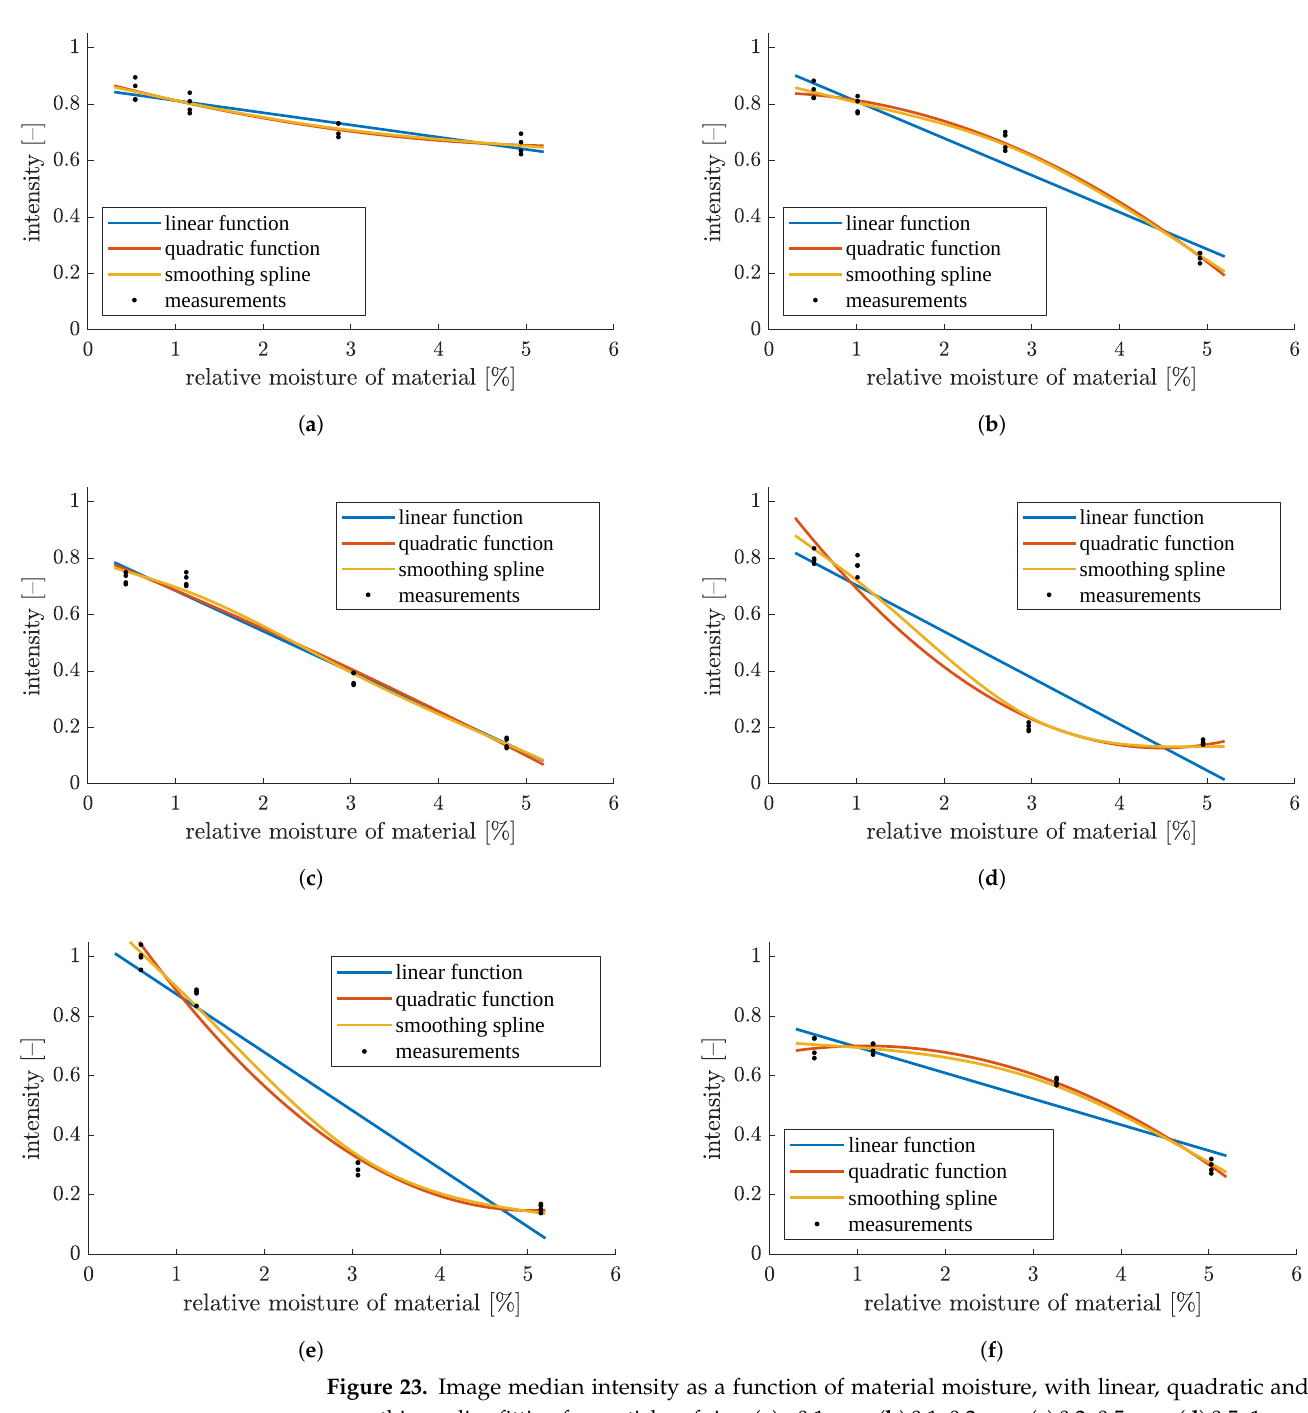
Figure 23. Image median intensity as a function of material moisture, with linear, quadratic and smoothing spline fitting for particles of size: ( a ) <0.1 mm, ( b ) 0.1–0.2 mm, ( c ) 0.2–0.5 mm, ( d ) 0.5–1 mm, ( e ) 1–2 mm and ( f )